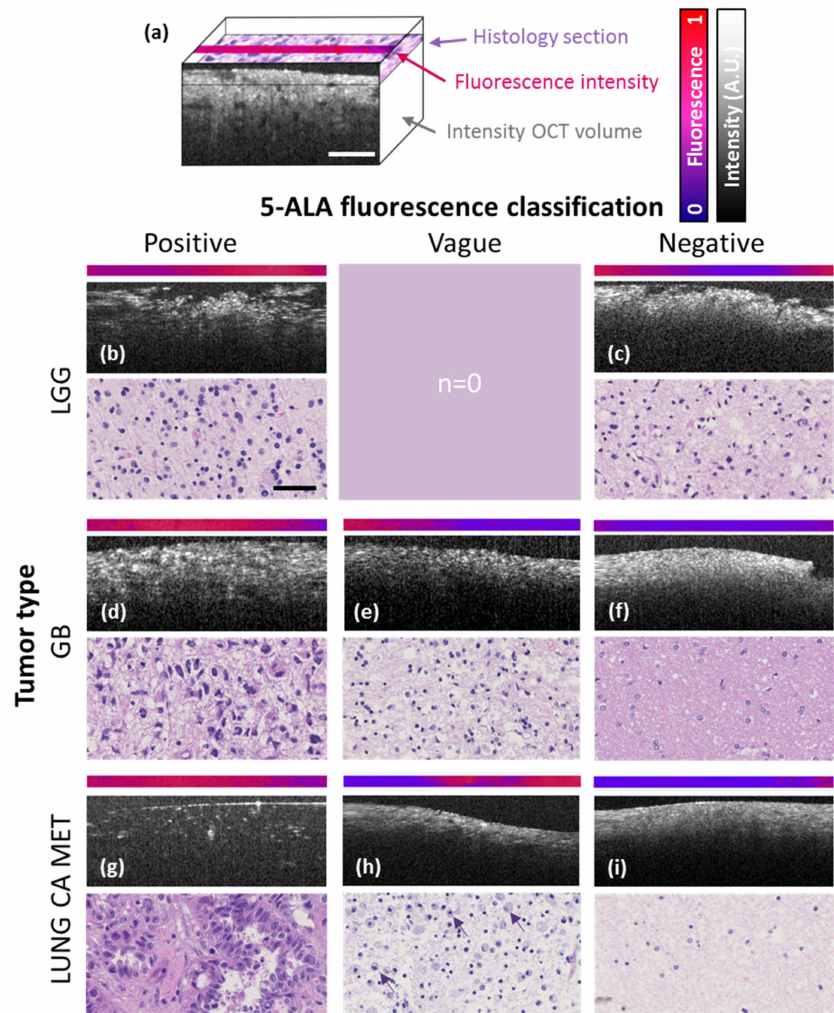
Figure 1. Cross-sections and digital pathology scans of representative tumor samples for each tumor entity evaluated in the study. Each panel features a 2.5- µ m-thick line of the fluorescence micrograph and the corresponding OCM (optical coherence microscopy) B-scan image. Corresponding histological sections are shown below. ( a ) Schematic 3D representation provides orientation of feature extraction planes. ( b , c ) LGGs (lower-grade gliomas) with strong ( b ) and without ( c ) 5-ALA (5-aminolevulinic acid) fluorescence observed during fluorescence-guided surgery (FGS) respectively. ( d – f ) GB (glioblastoma) with strong ( d ), vague ( e ) and without ( f ) intraoperative 5-ALA fluorescence respectively. ( g – i ) Lung CA MET (lung cancer metastasis) with strong ( g ), vague ( h ) and without ( i ) 5-ALA fluorescence observed during FGS. Note, infiltration by macrophages in ( h ) indicated by purple arrows and necrosis in ( i ) throughout the tissue. Scale bars correspond to 50 µ